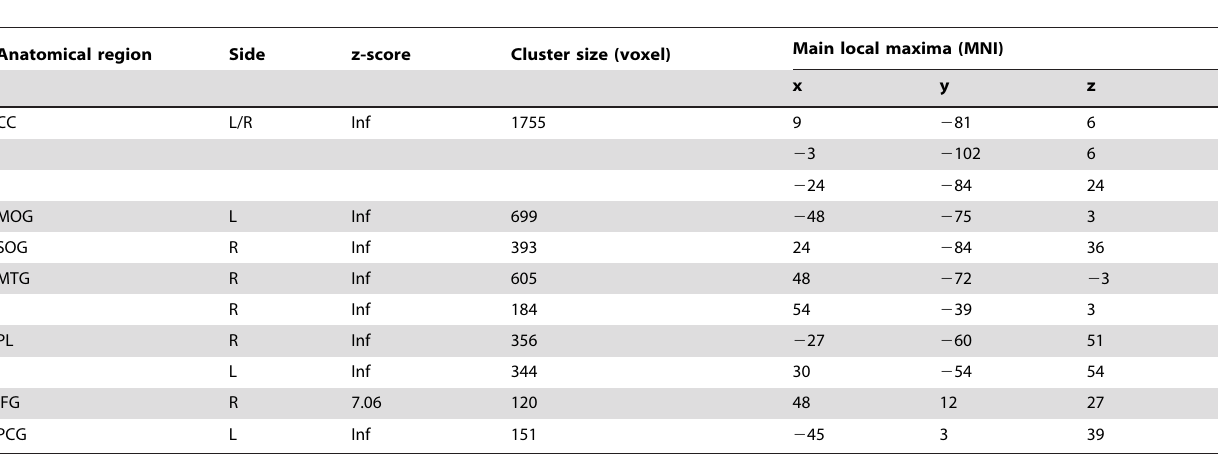
Table 1. Montreal Neurological Institute (MNI) coordinates of peaks of relative activation in the cortical regions where BOLD signal was significantly different during observation of any experimental condition compared with the intertrial baseline.